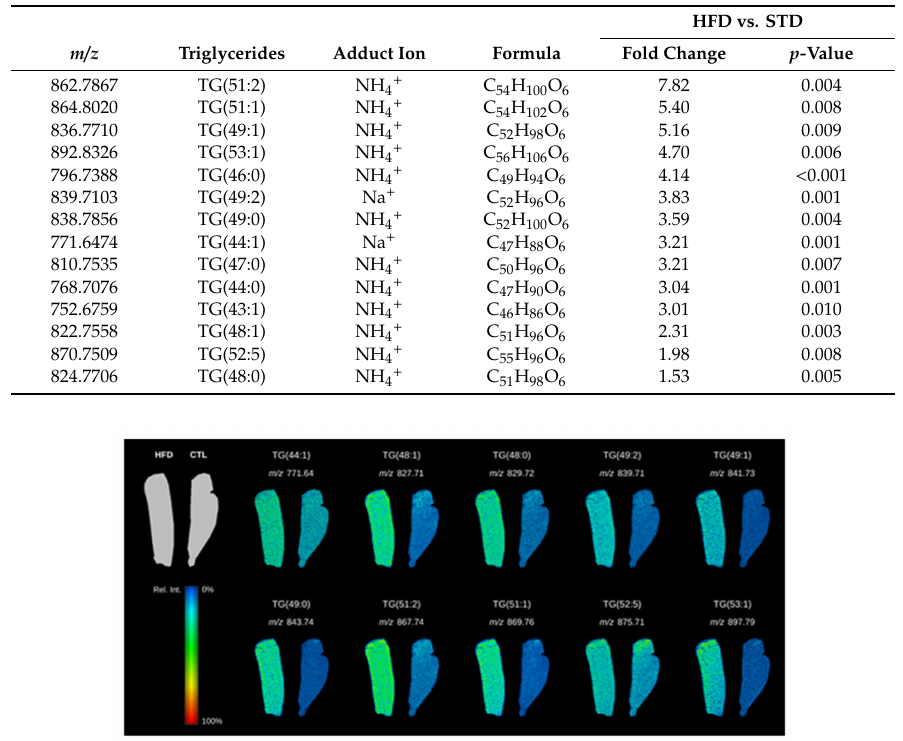
Table 1. Liver triglycerides upregulated in high-fat-diet (HFD)-fed mice. The accuracy for the m / z values reported is < 0.005 ppm.